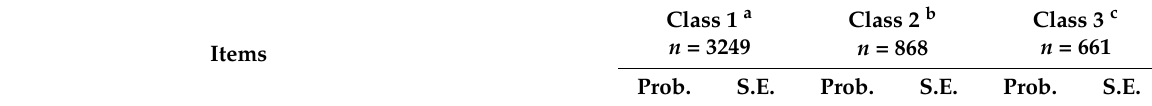
Table 4. Endorsement Probability for Each Item by Latent Class.